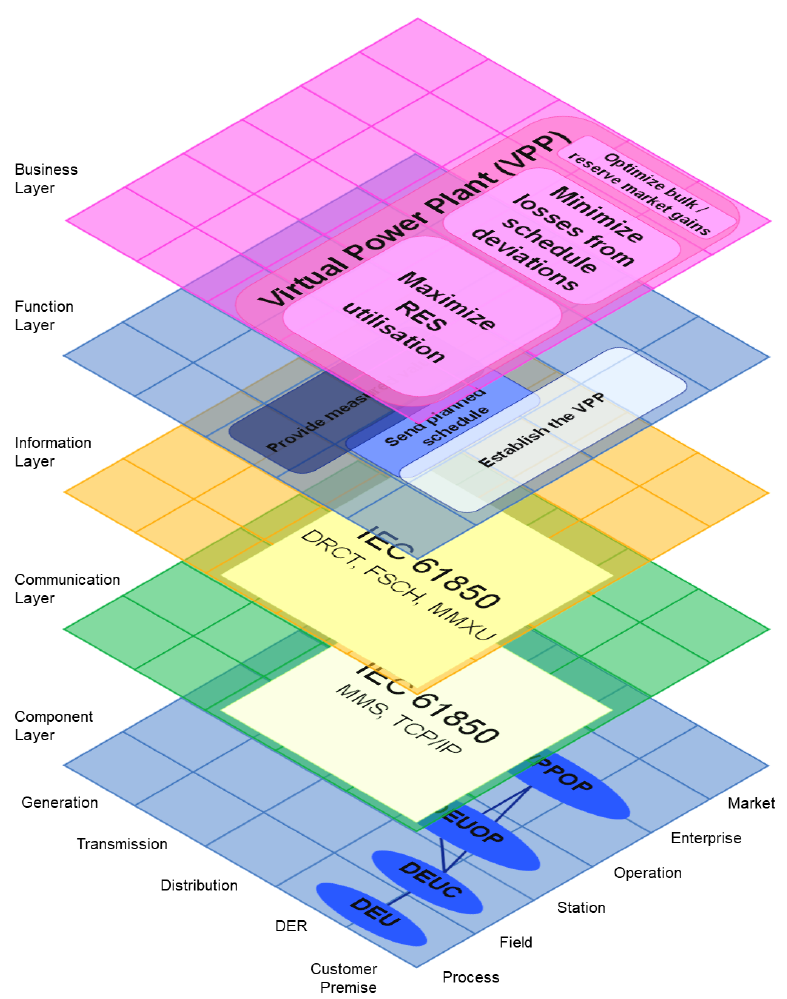
Figure 9. Positioning of features in the three-dimensional SGAM: selected VPP features mapped onto the three reference designation